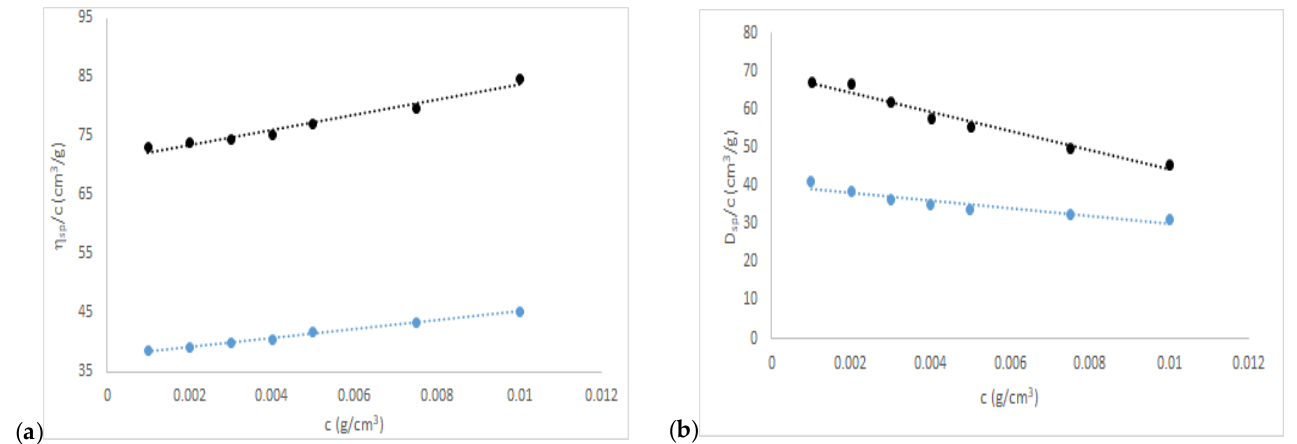
Figure 1. ( a ) Intrinsic viscosity and ( b ) diffusion coefficient of chañar gum solutions; the blue line is CHA and the black line is CHT. Table 1. Hydrodynamic data.